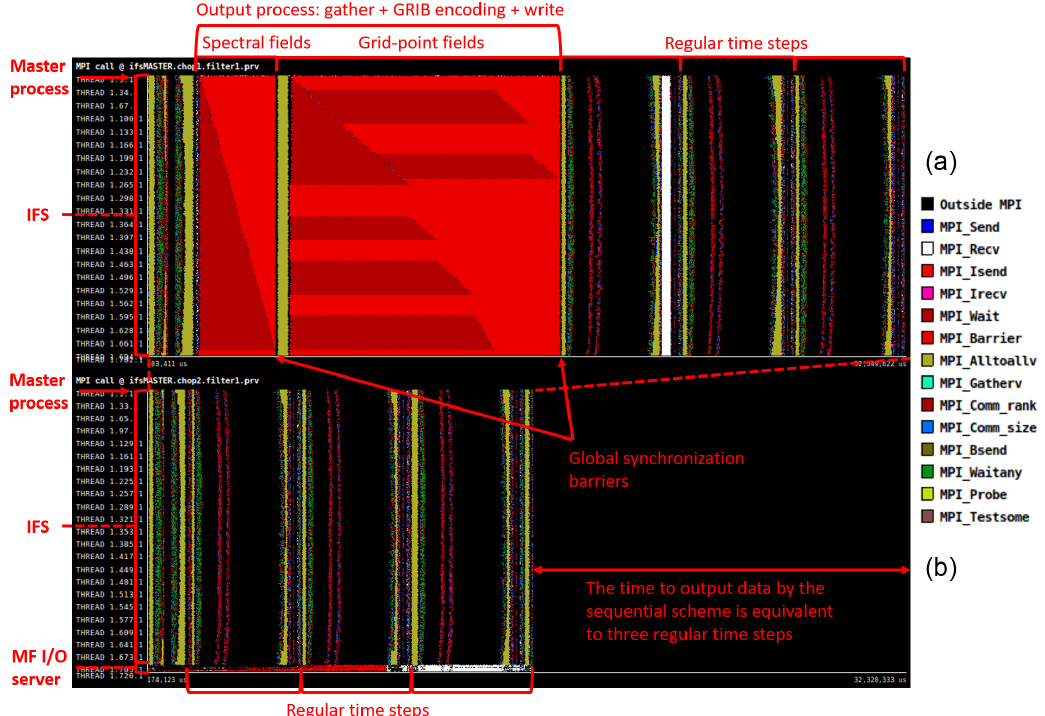
Figure 2. Panel (a) illustrates the serialisation caused by the sequential output scheme, whereas panel (b) illustrates the fact that IFS with the internal parallel I/O server runs efficiently with no observable delays. Both traces have the timeline on the x axis and the MPI processes on the y axis. Along the timeline, many MPI call events happen, with each colour representing an MPI function.